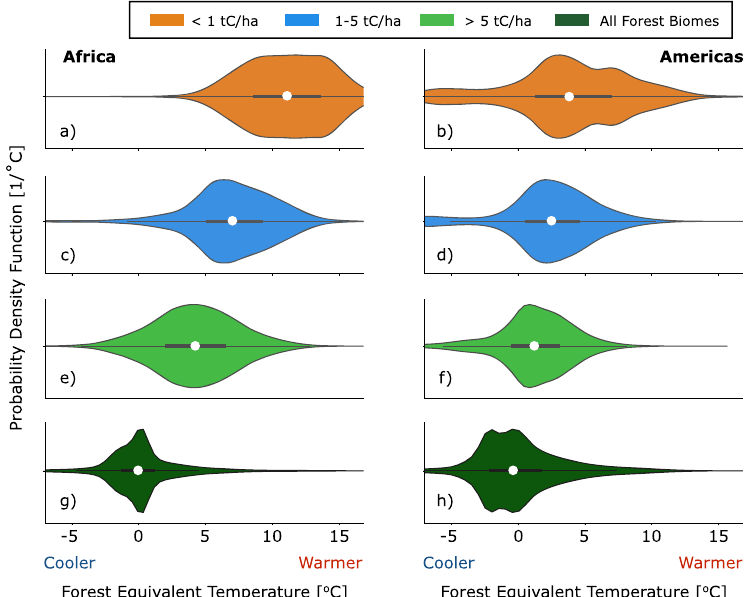
Fig. 2 Forest Equivalent Temperature (FET) by silvopasture density. Violin plots of FET in each 1 km 2 pixel of pasture regions in the Americas and Africa binned by the local woody carbon density in tC/ha, along with a violin plot of FET in each 1 km 2 pixel of forested regions. In the violin plots, the thick black line in the middle shows the interquartile range and the white circle in the center shows the median value. The probability density functions are smoothed with a Gaussian kernel in each subset of